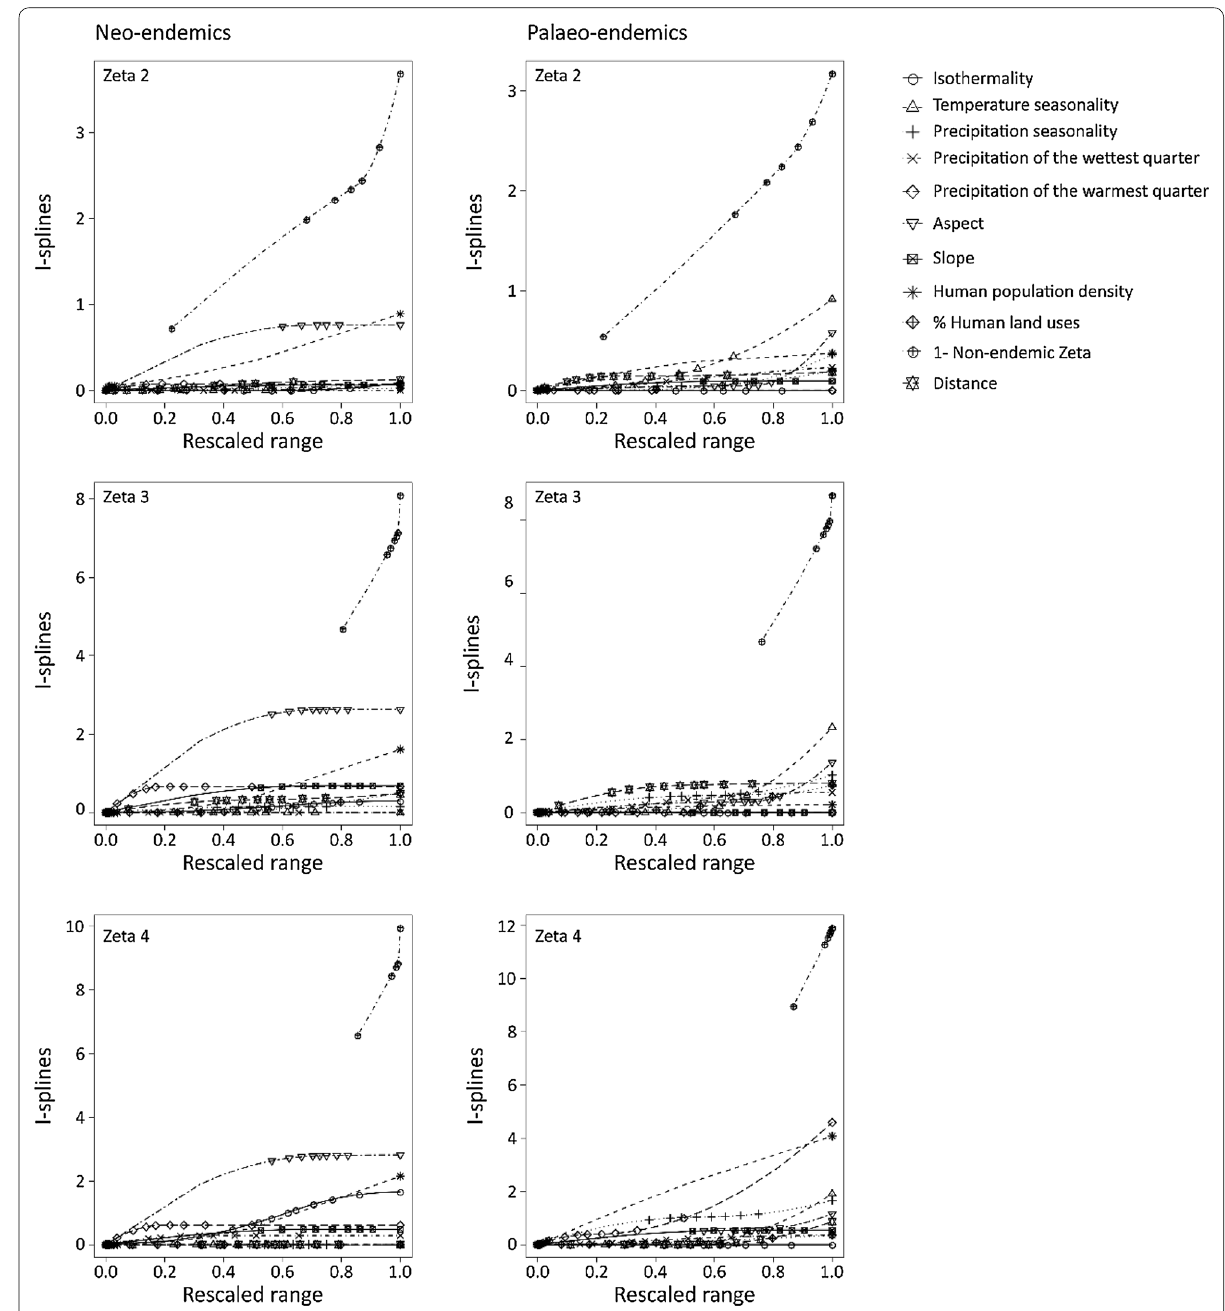
Fig. 3 The effects of non‑endemic zeta diversity, environmental variables and distance on differences in zeta diversity for different zeta orders estimated by Sørensen index for neo‑endemic and palaeo‑endemic vascular plants of Crete, Greece, as were estimated by multi‑site generalized dissimilarity biotic model I. The predictors were transformed with I‑splines